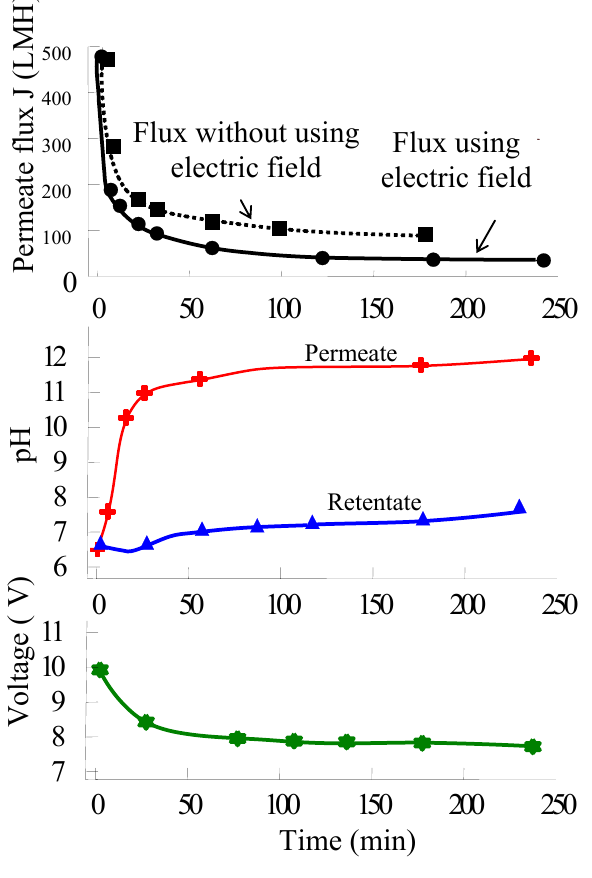
Figure 7. The pH divergence of the permeate and retentate in a continuous run of EMF, in which the membrane worked as a cathode (Current density: 53 A/m 2 ; Alamin